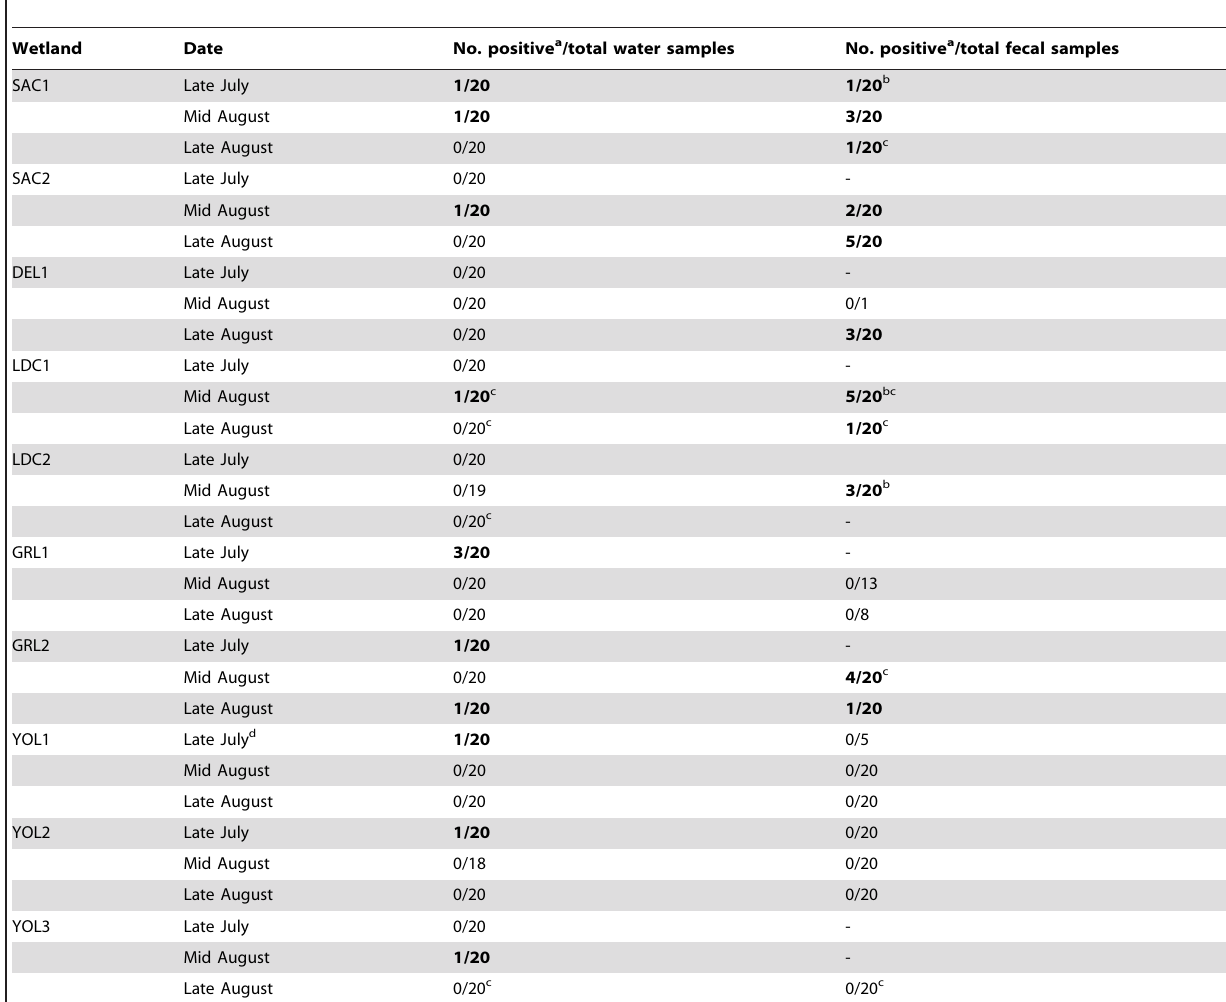
Table 1. Number of AIv RNA-positive water and fecal samples at each wetland of the California Central Valley for the three sampling